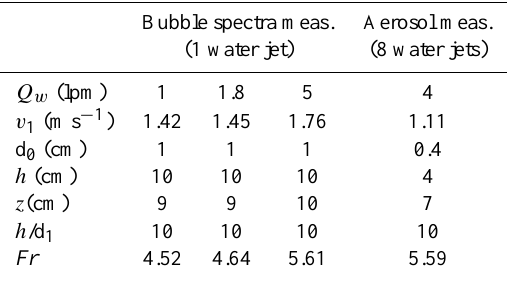
Table 2. Summary of experimental conditions for the bubble spec- Table 1. Summary of experimental conditions for the bubble spec- trum (1 water jet) and aerosol characterization measurements (8 wa- trum and aerosol characterization measurements conducted with ter jets) in the small-scale plunging water jet system in this study. spargers as bubble generators. Q air =total air flow through the Q w =total water flow, v 1 =mean jet velocity at the water surface, porous media, z =depth below water. Sweep air flow in the tank d 0 =nozzle diameter, d 1 =water jet diameter at the water surface, head space was ∼ 3lpm. which is assumed ∼ d 0 , h =vertical distance from the nozzle to the water surface, z =penetration depth. Inflow conditions are defined Bubble spectra meas. Aerosol meas. by h/d 1 and Fr =Froude number= v 1 /(gd 1 ) 0 . 5 with g=gravity accel- eration (9.81ms − 2 ). Sweep air flow in the tank head space was ∼ 3lpm. Bubble spectra meas. Aerosol